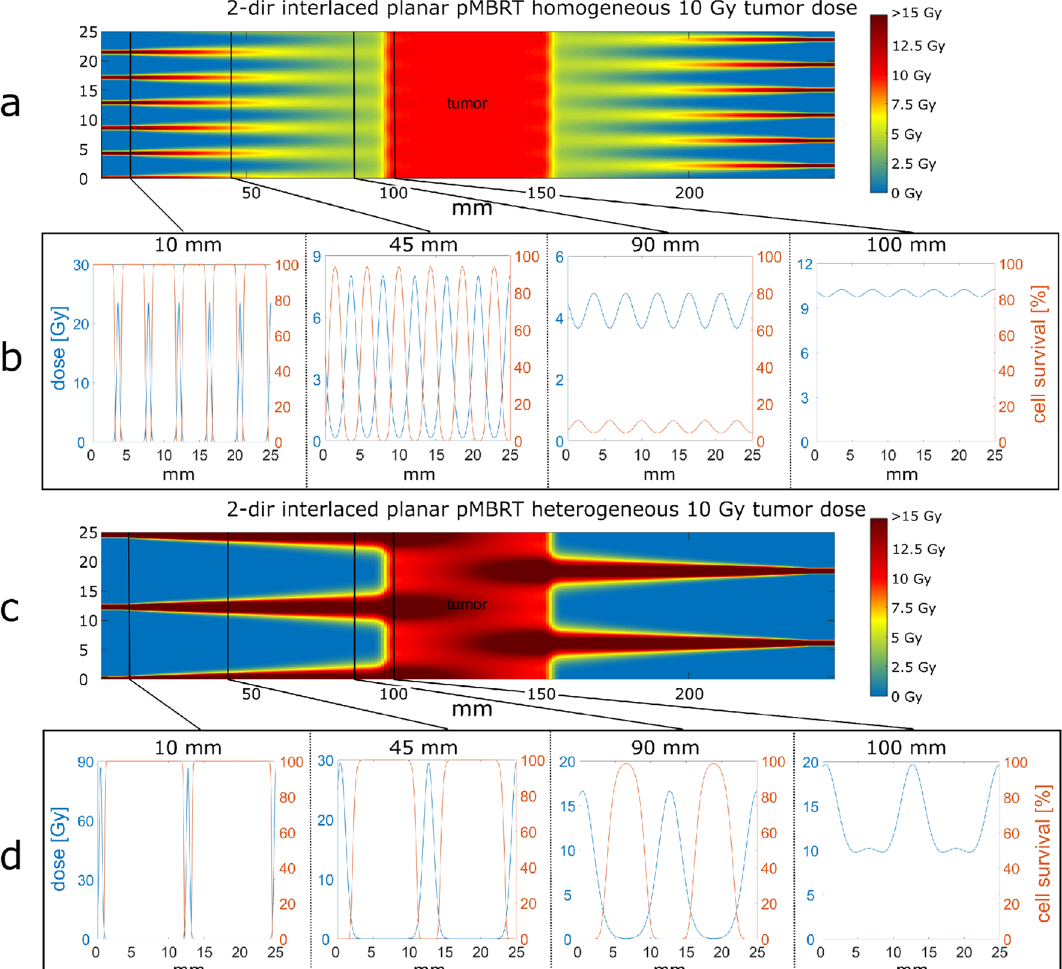
Figure 2. Dose maps of 2-dir interlaced planar minibeams (cf. Fig. 1c) with homogeneous ( a ) and heterogeneous ( c ) tumor dose. The dose is color-coded with saturation at 15 Gy. The cross-section of dose and the local clonogenic cell survival at 10, 45, 90 and 100 mm depth are shown for homogeneous ( b ) and heterogeneous ( d ) tumor irradiation with 10 Gy mean or minimum tumor dose, respectively. Heterogeneous tumor irradiation is described in section